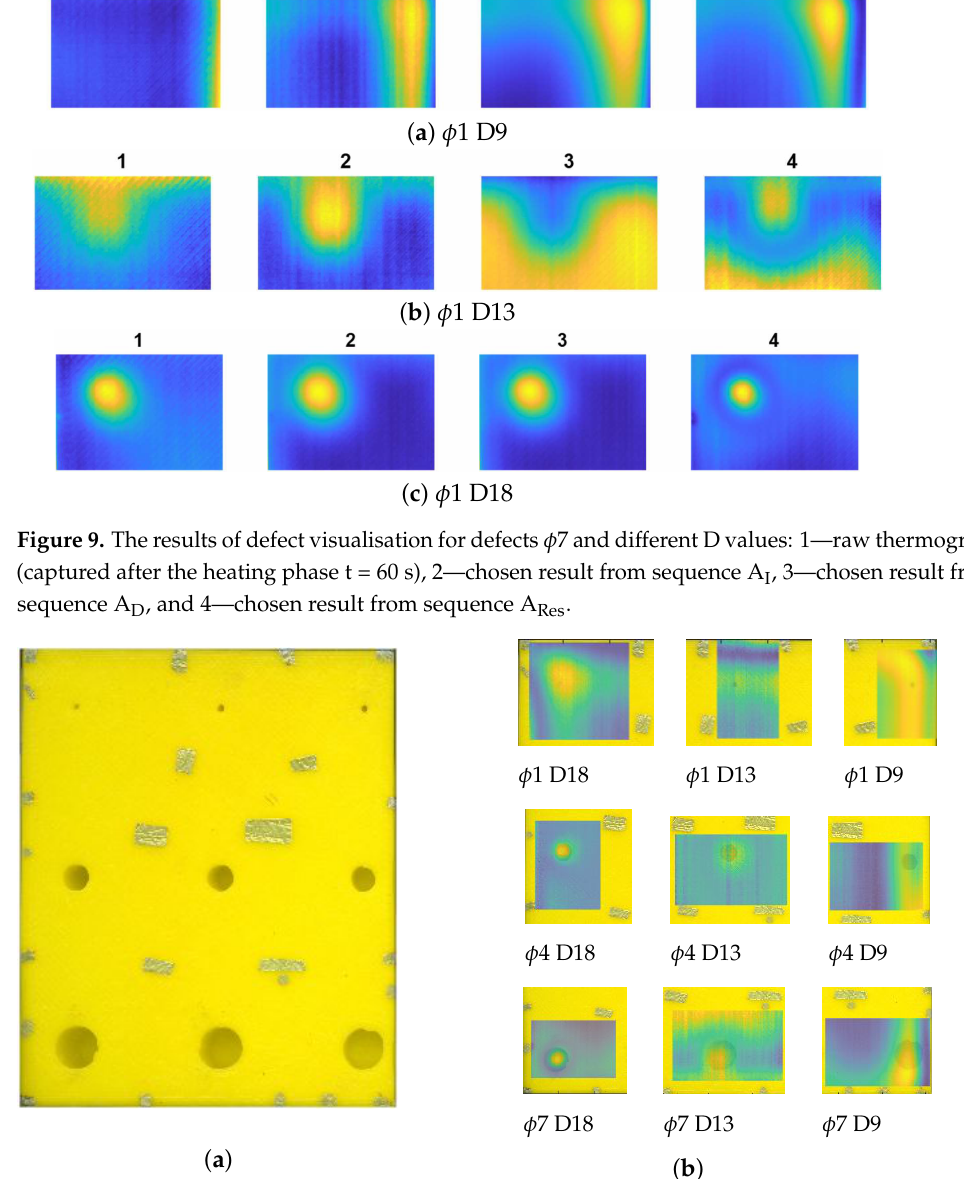
Figure 10. The results of the defect visualisation algorithm presented for the whole sample. ( a )—the overlaid photos of the front and back of the sample, showing the exact positions of the defects against the position of corresponding markers. ( b )—chosen best images from the A Res sequence overlaid on the top of the original photo of the